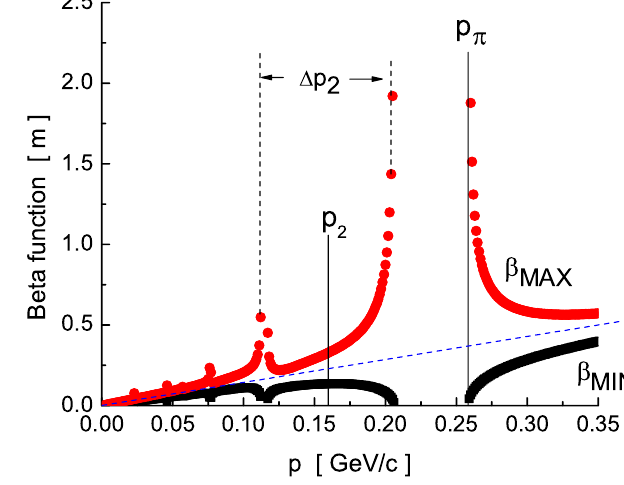
FIG. 3. Trace of the one-cell transport matrix versus momen- tum. The parameter values were d (cid:2) 100 cm , L (cid:2) 67 : 1 cm , a (cid:2) 43 : 6 cm , t (cid:2) 12 : 6 cm , J (cid:2) 40 A = mm 2 , and alternating po- larity.